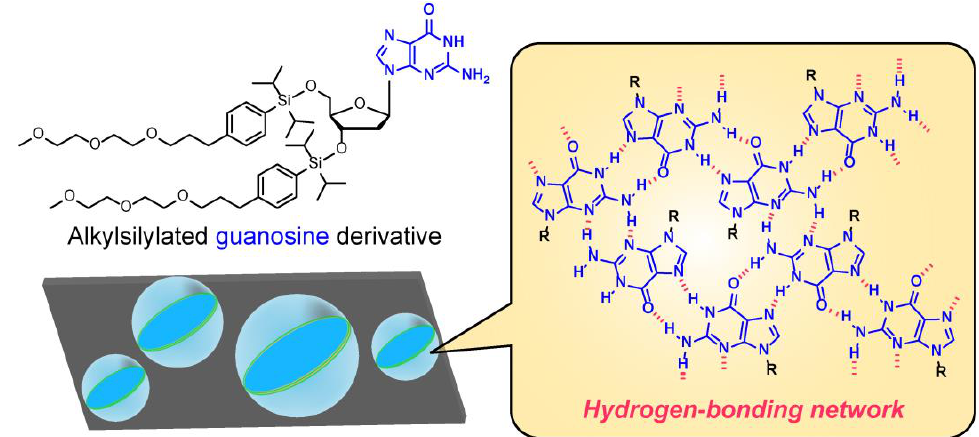
Figure 3. Schematic illustration of the hydrogen - bonding network of guanosine derivatives with alkyl silyl groups that results in the stable vesicles.